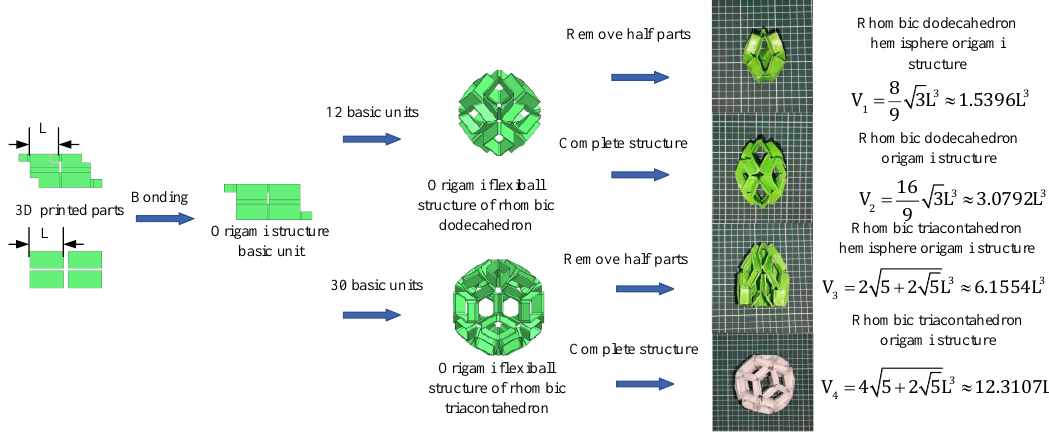
Figure 1. Two types of origami flexiballs and their variants.